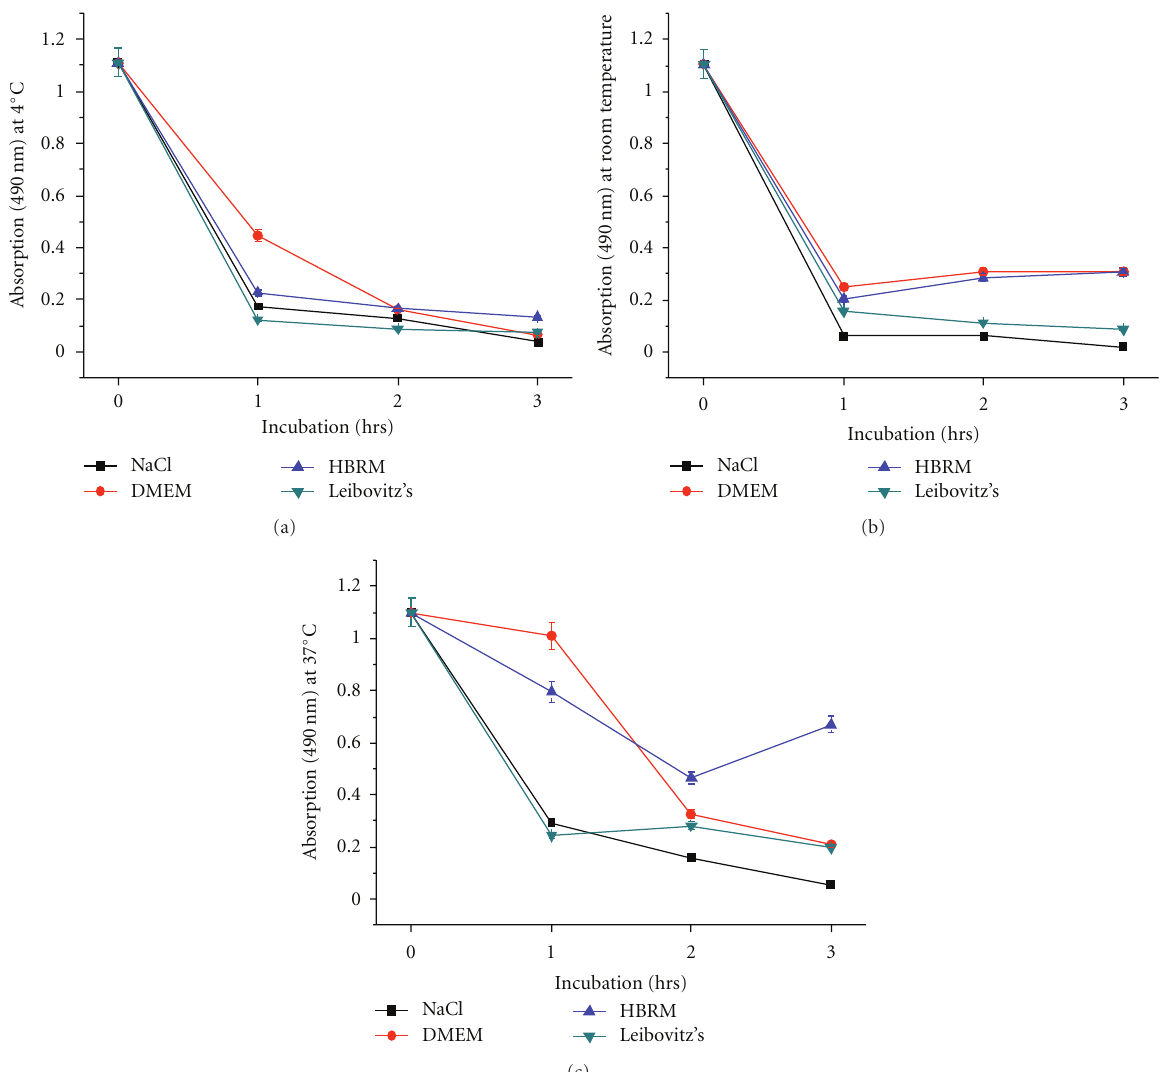
Figure 4: Schwann cell metabolism indicated as absorbance measured with MTS at 4 ◦ C (a), room temperature (b), and at 37 ◦ C (c) incubated in the described media. At 4 ◦ C all conditions resulted after 3 hours in massive reduction of cell viability. At room temperature incubation in HRBM and DMEM showed slightly better results than NaCl and Leibovitz’s. Optimal cell viability with increase of Schwann cell metabolism can be seen after incubation in HBRM at 37 ◦ C as observed by independent determination of cell viability by CTB in Figure 2. P < 0 .